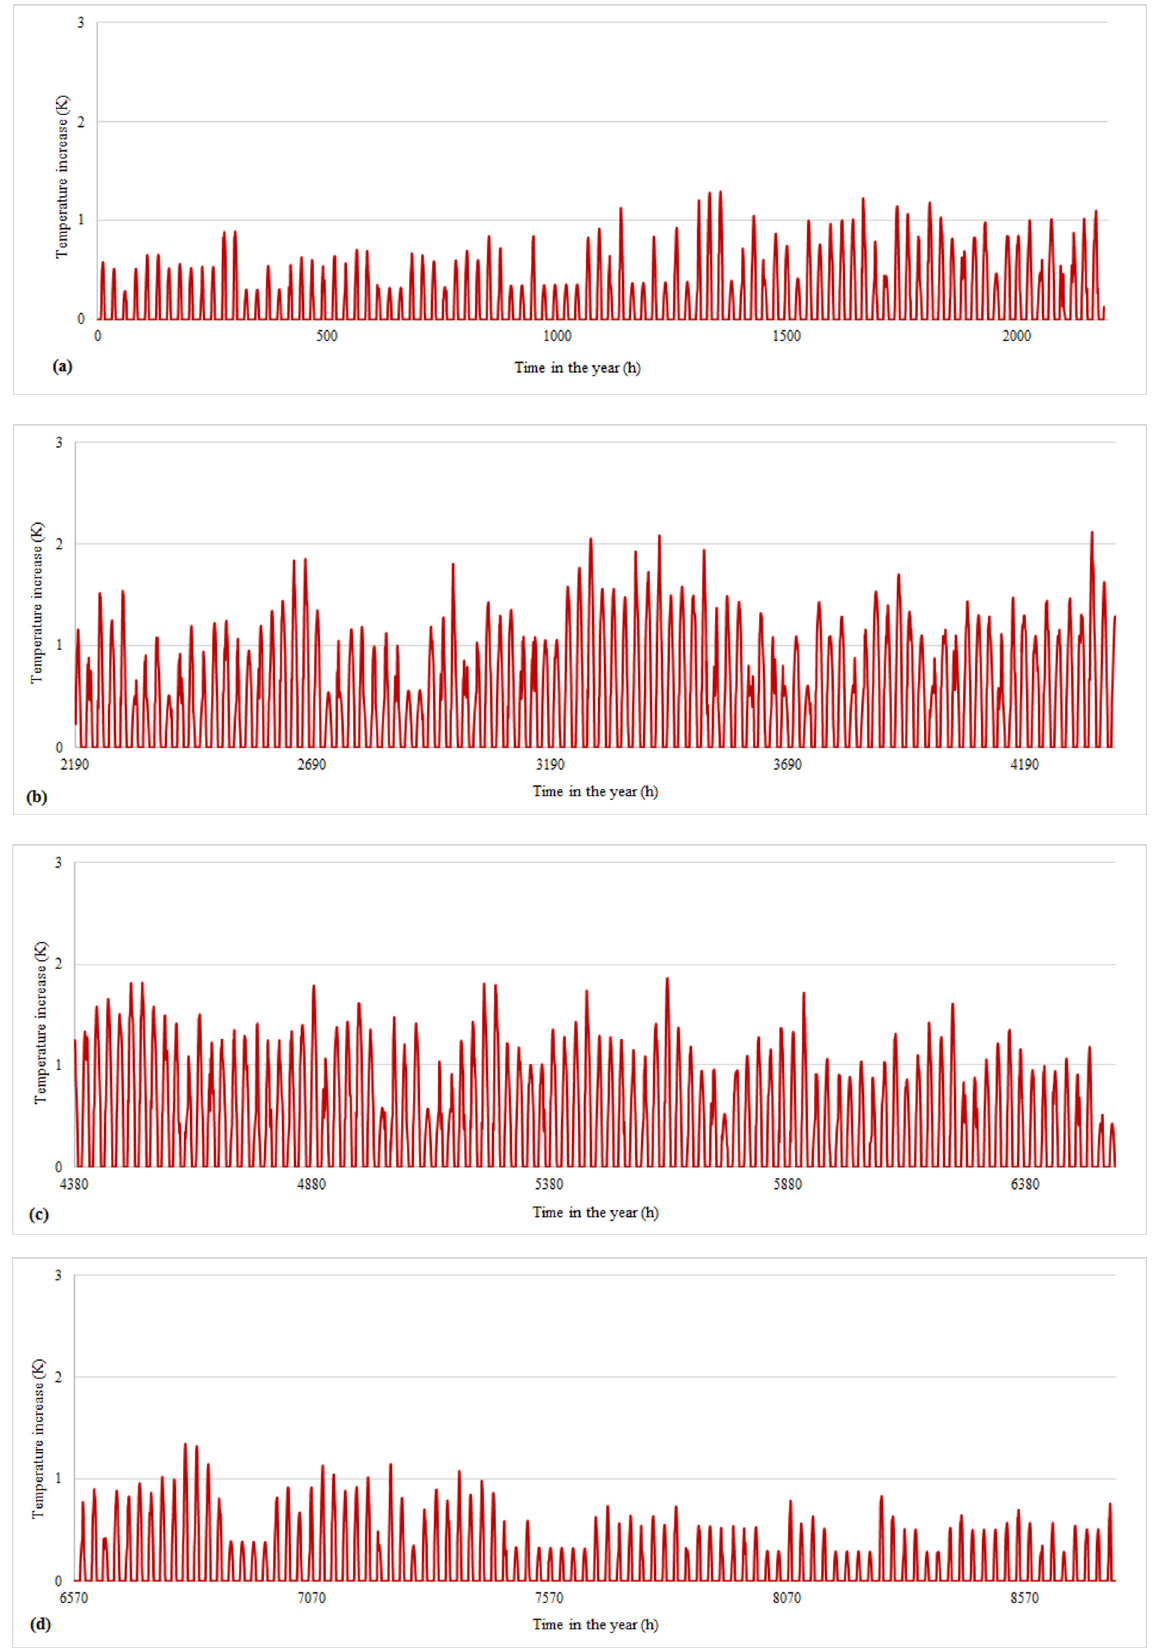
Figure 4. ( a – d ). Temperature increase ΔT = T f − T a in the collector in each quarter of the year. The lowest temperature increases are observed in the first and fourth quarters, and the smallest temperature increase, which amounts to 0.01 K, was on 29 March at 5.00 p.m. Low temperature increases result from low solar radiation heating the collector. The high- est increases in air temperature occurred in the second quarter, which is related to higher solar radiation intensity. The maximum temperature increase occurred on 30 June at 10:00 a.m. and amounted to 2.12 K. Figure 5a–d presents the air velocity in the solar chimney for each quarter of the year. The air speed depends on the air temperature increase in the collector, and therefore the highest air velocities are observed in the second and third quarters, when the air temper- ature increase in the collector is the highest. In the second quarter, the maximum achieved air speed was 3.70 m/s; in the third quarter, the maximum air speed was 3.47 m/s. In the first quarter, the maximum air speed of 3.00 m/s was achieved, while it was 2.97 m/s in the fourth quarter. The lowest air velocities, when the sun’s rays fall on the installation, are similar to each other—in the second and third quarters, the air velocity is 0.3 m/s, 0.27 m/s in the first quarter, and 0.32 m/s in the fourth quarter.